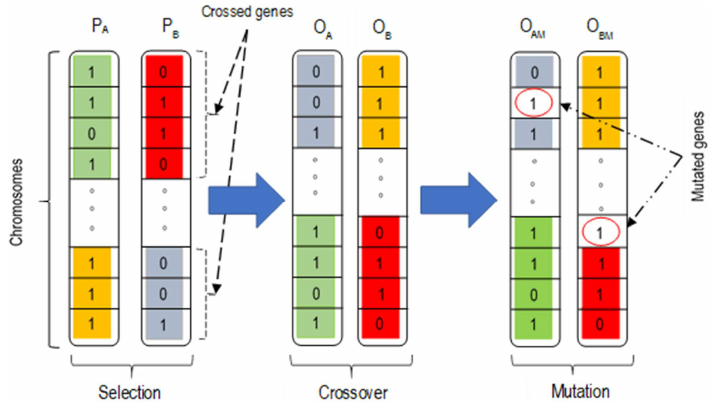
Figure 1. Chromosomes, genetic arrangement, selection, crossover and mutation procedures in the genetic algorithm (GA): P A and P B represent original parents’ chromosomes; O A and O B are offspring from the parents; O AM and O BM are offspring with mutated genes.